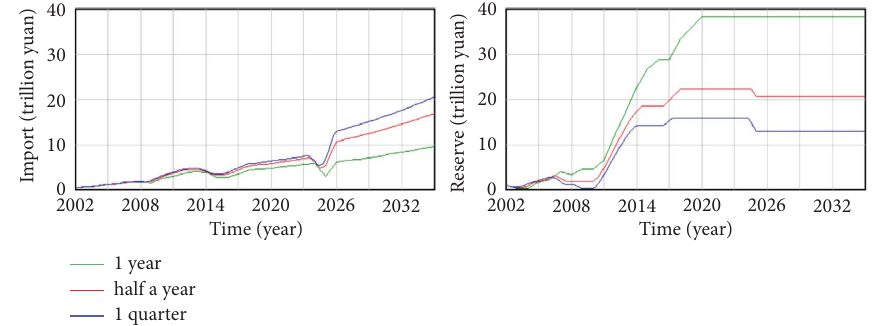
Figure 4: Sensitivity analysis of mineral resources industry under supply chain